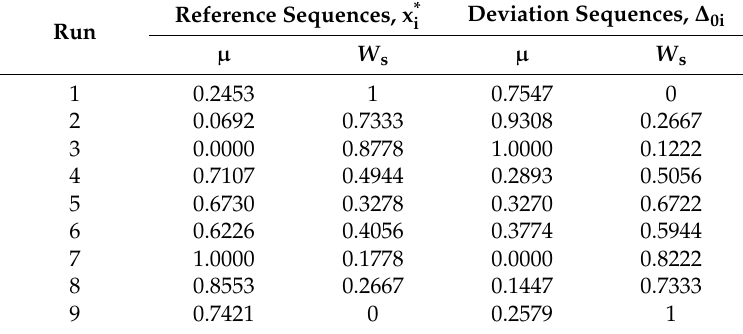
Table 8. Reference and deviation sequences after data pre-processing.